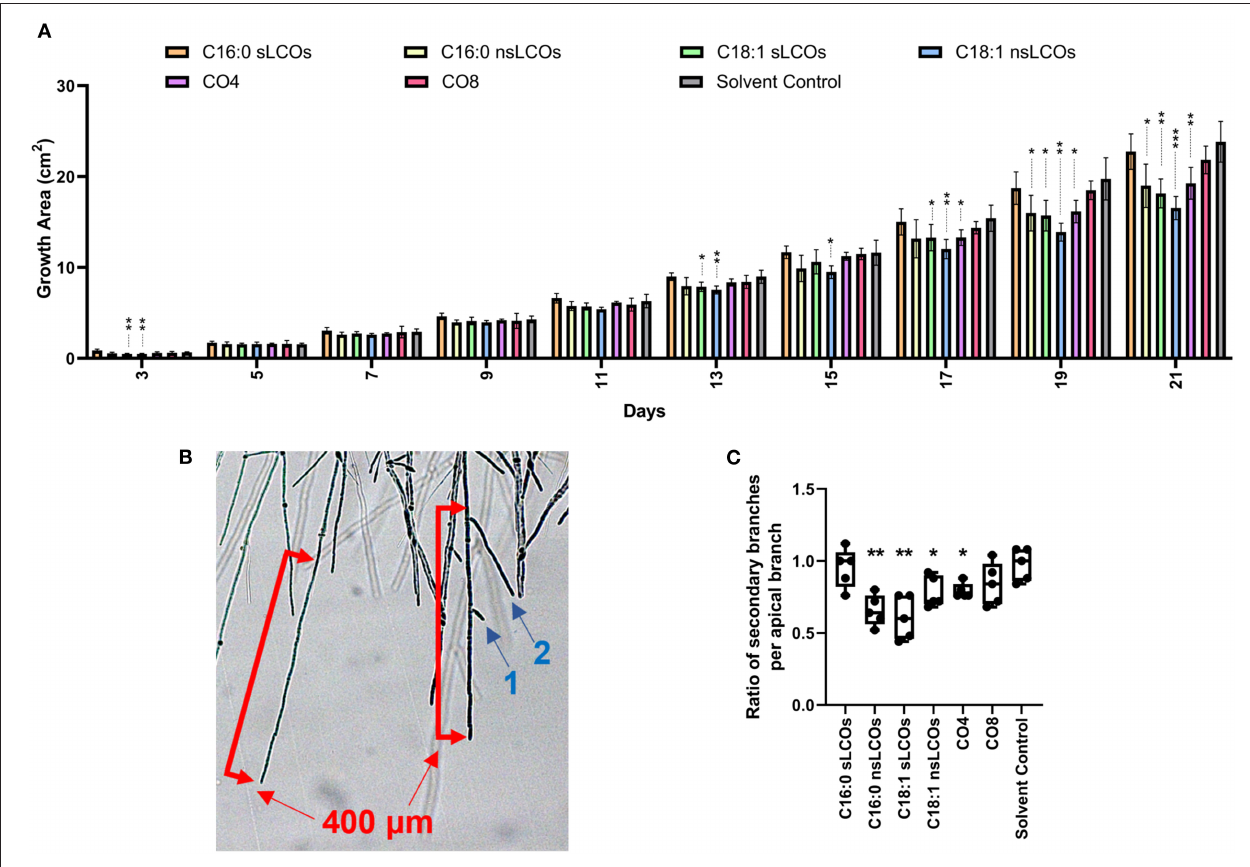
FIGURE 1 | LCOs and COs effect on growth and hyphal branching. (A) Growth of Laccaria bicolor over 21 days when exposed to LCOs or COs. Diameter measurements were taken every other day, starting on the day 3. Fungal growth is the area without the 1 cm 2 plug. Welch’s ANOVA test was significant for 3 days post-inoculation (dpi) ( p = 0.0058), 11 dpi ( p = 0.0032), 13 dpi ( p = 0.0079), 15 dpi ( p = 0.01), 17 dpi ( p = 0.0199), 19 dpi ( p = 0.0005), and 21 dpi ( p = 0.0004). Treatments were compared to the solvent controls with Welch’s unpaired t -test. N is five biological replications. (B) Hyphal branching was determined by the average ratio of secondary branches (indicated by blue arrows and numbers) to 400 µ m of the apical branch (red scale bar) counted after 3 dpi. (C) The ratios of secondary branches per apical branch in treatments were compared to the solvent controls with Welch’s unpaired t -test (Welch’s ANOVA test p = 0.0105). N is five biological replications with five technical replications each where five apical branches were counted. For all measurements containing significant treatments compared to the solvent control are as follows: (*) is a p < 0.05; (**) is a p < 0.01; (***) is a p <